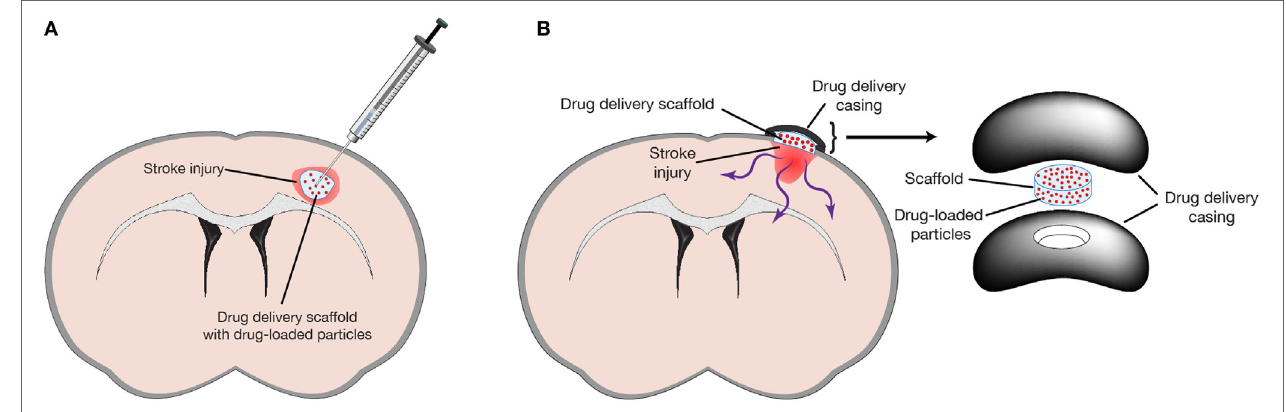
FiGURe 1 | Biomaterials can be used to delivery drugs by either (A) intracranial injection into space provided by the stroke injury or (B) epi-cortical implant on the surface of the brain to prevent any further damage due to injection. Reprinted from Tuladhar et al. (2015) with permission from